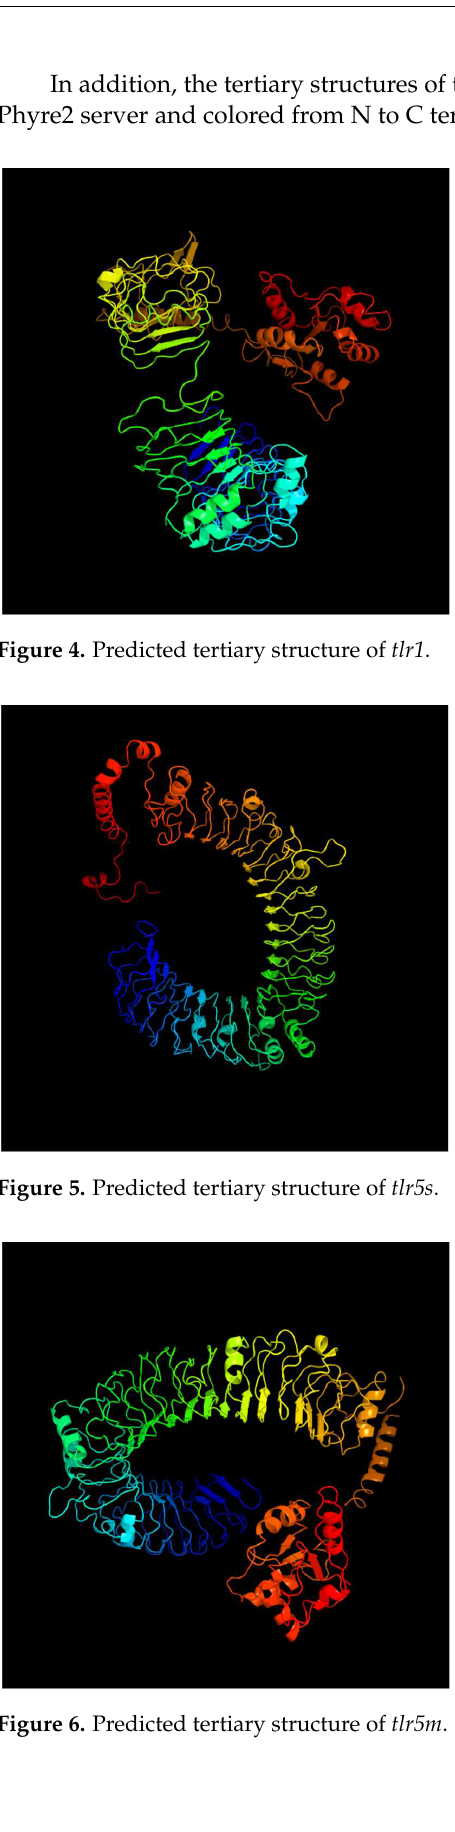
Figure 7. Predicted tertiary structure of tlr14.